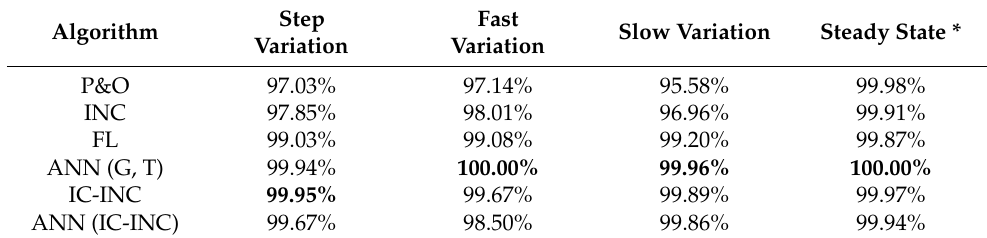
Table 3. Simulation results of MPPT efficiency.